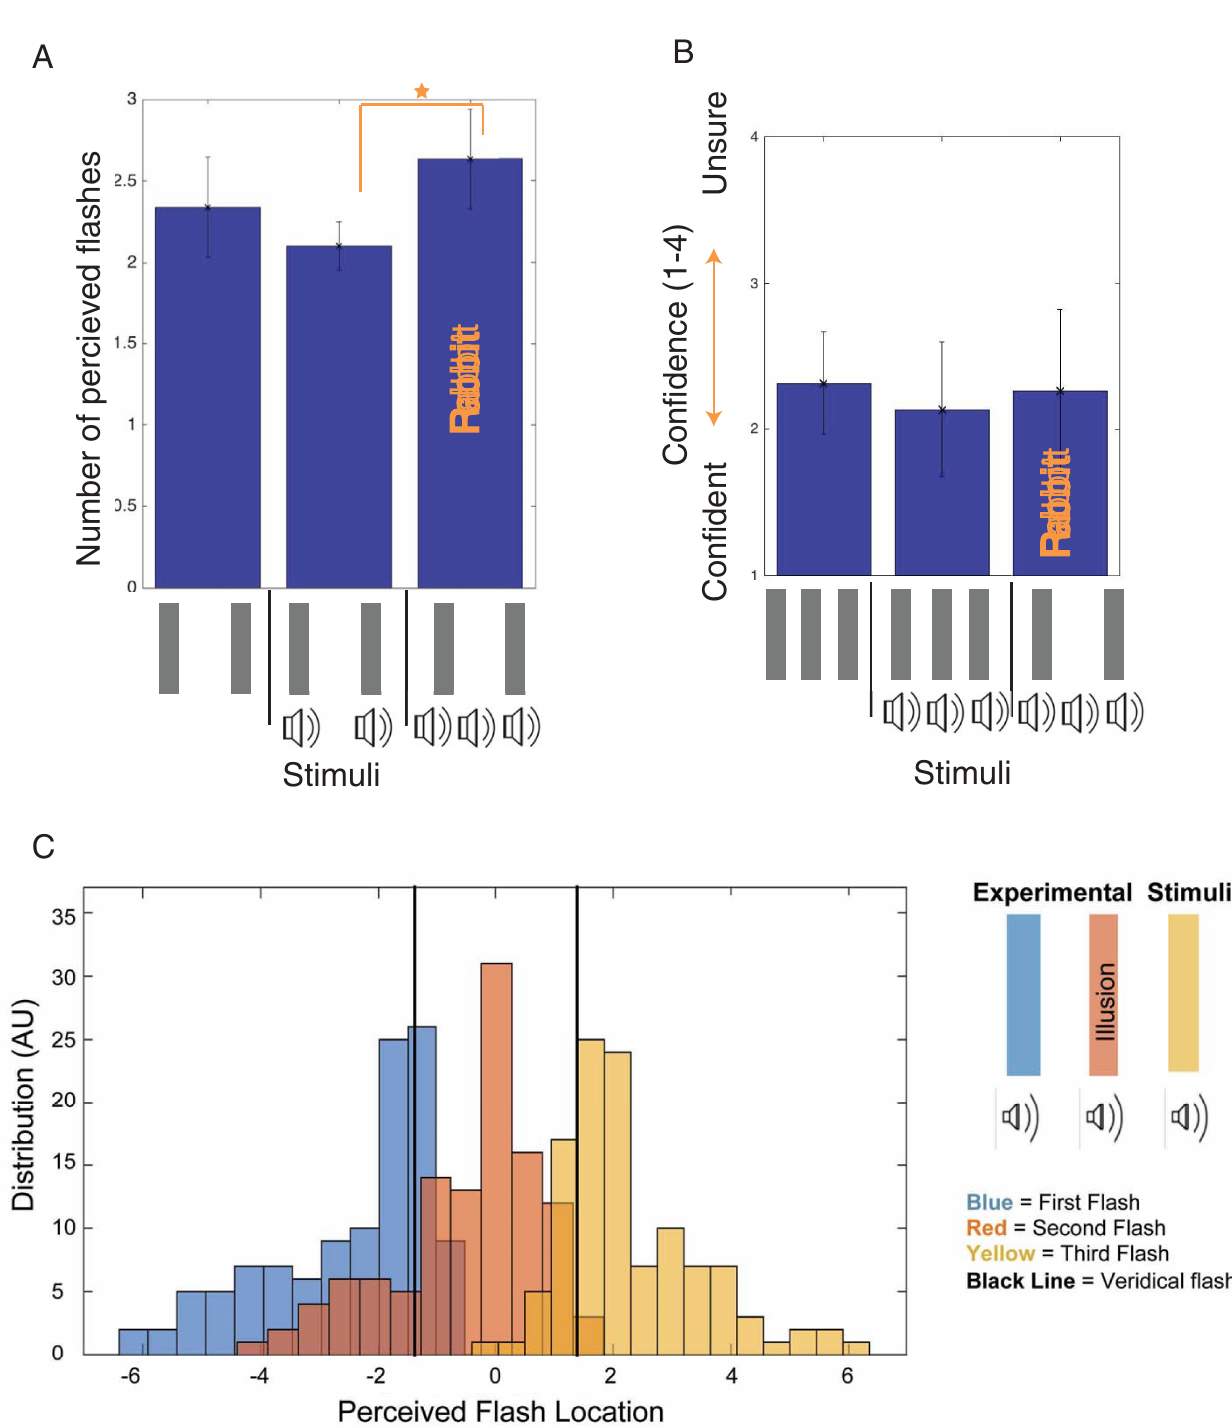
Fig 3. Illusory AV rabbit results. Fig 3A plots the number of flashes perceived for several beep and flash stimuli presented in Experiment 1.1. Fig 3B shows the confidence rating reported for perceiving three flashes for the Illusory AV Rabbit stimulus in comparison to non-illusory stimuli. Fig 3C plots the reported flash locations (in centimeters) across participants for the Illusory AV Rabbit stimulus, when three flashes are reported. Error bars are standard